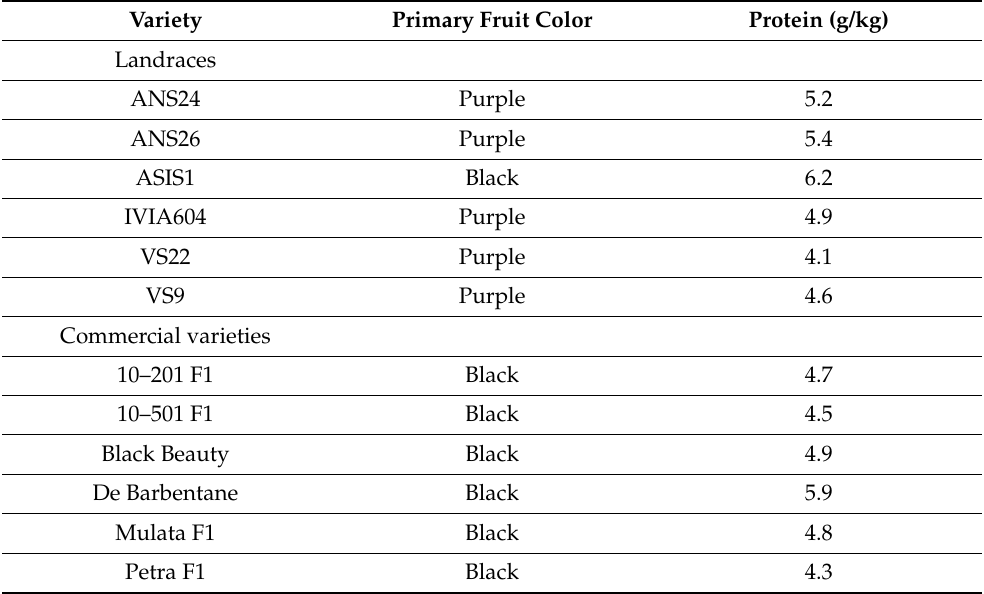
Table 1. Variation for protein content in g/kg of fresh weight in different eggplant cultivars, adapted from Raig ó n et al. [32].